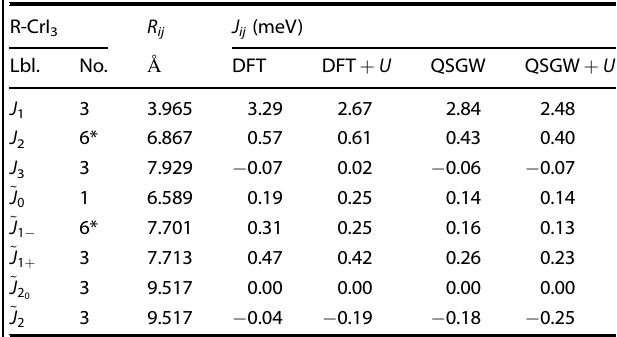
and ~ J 2 . AFM ~ J 2 corresponds to a Cr-I-I-Cr super- 0 ~ J ~ J ¼ J = 12 ) model and a J ¼ J = 6 ) ( ~ J 2 ¼ ~ J 2 1 2 ( 2 1 1 - 0 0 ^ k z direction; the exchange parameters Table 1. Pairwise intralayer ( J i ) and interlayer ( ~ J i ) exchange parameters in R-CrI 3 calculated within various